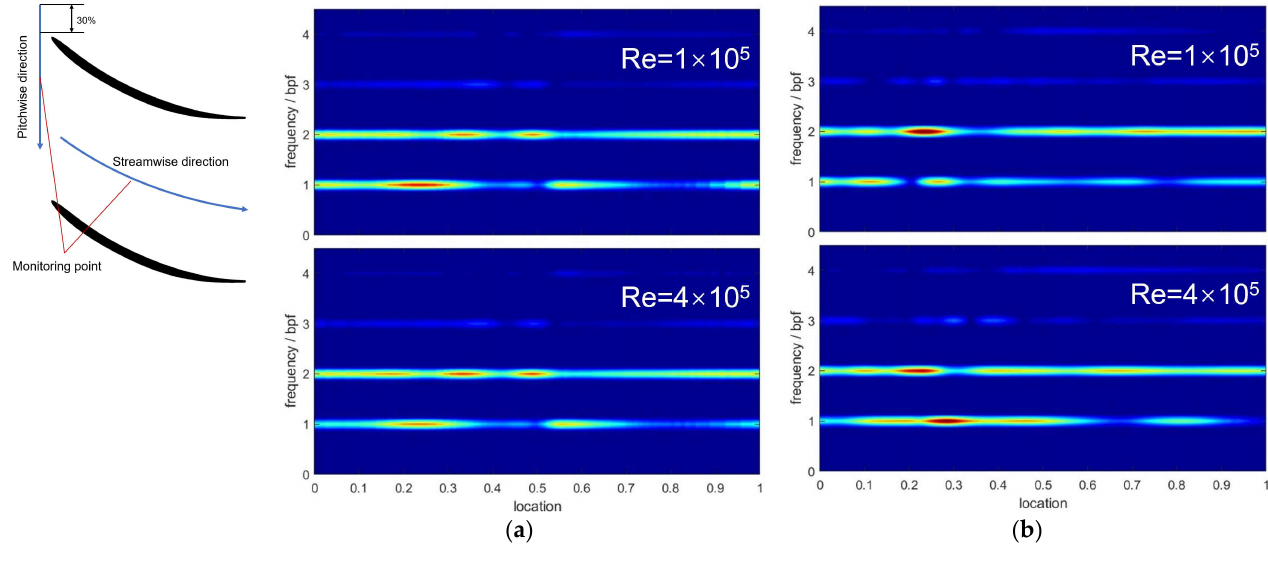
Figure 21. The amplitude-frequency characteristics of the monitoring points at 99% span and monitoring point location. ( a ) Along the pitchwise direction; ( b ) along the streamwise direction.